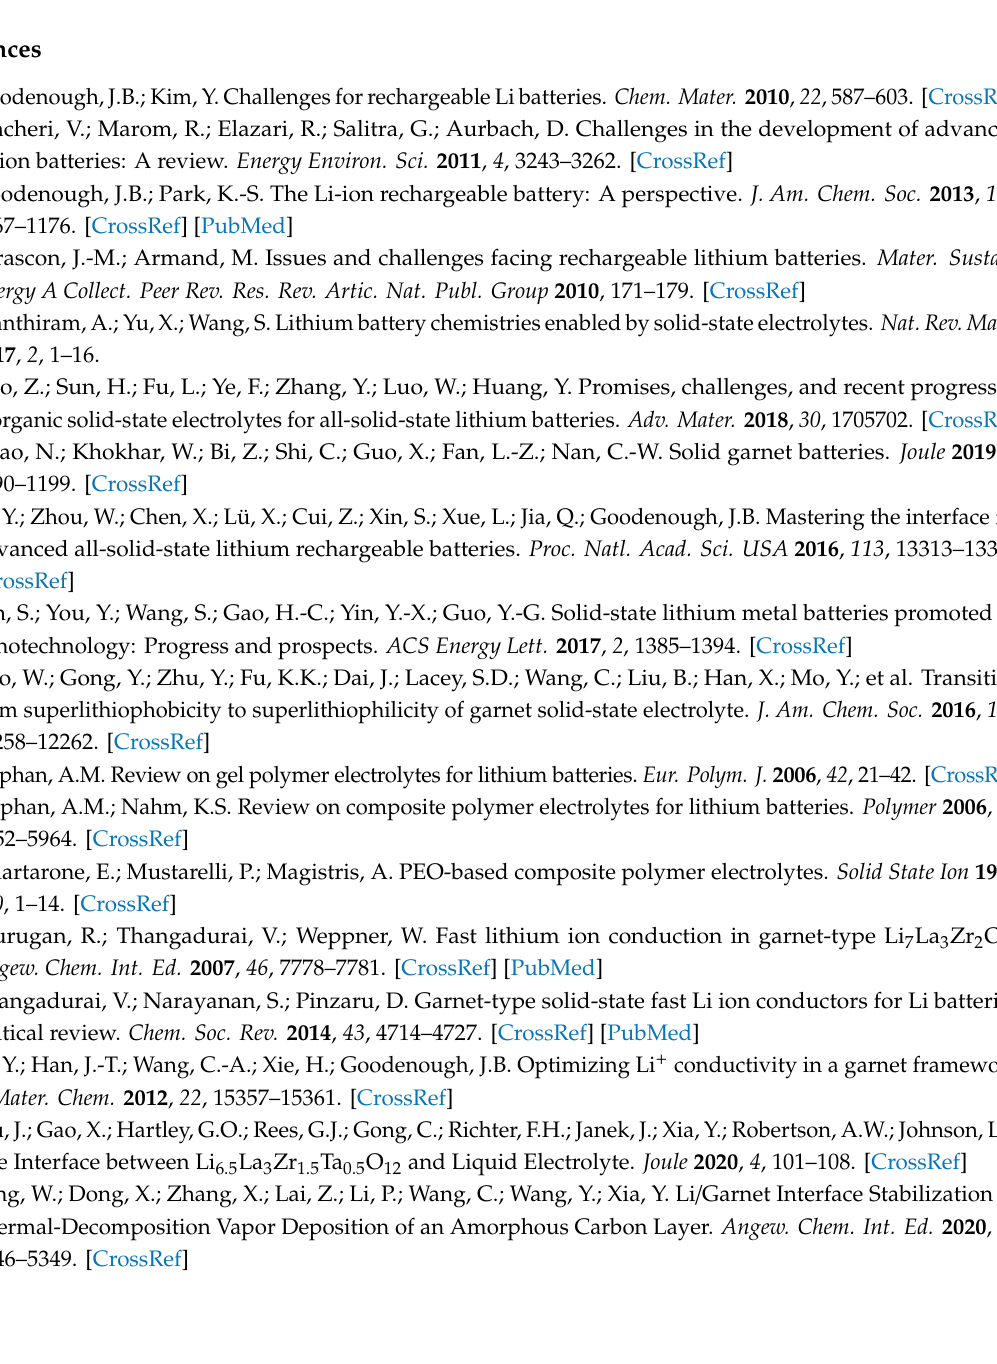
fitting, Figure S3: Relative densities of Li 1 + x Y x Zr 2-x (PO 4 ) 3 (0.1 ≤ x ≤ 0.2) pellets treated by regular sintering and hot-pressing from 1100 to 1250 ◦ C, Figure S4: SEM images of LY 0.1 ZP pellets prepared by hot-pressing from 1100 to 1250 ◦ C, Figure S5: Nyquist plots of Li 1 + x Y x Zr 2-x (PO 4 ) 3 (0.1 ≤ x ≤ 0.2) pellets prepared by regular sintering